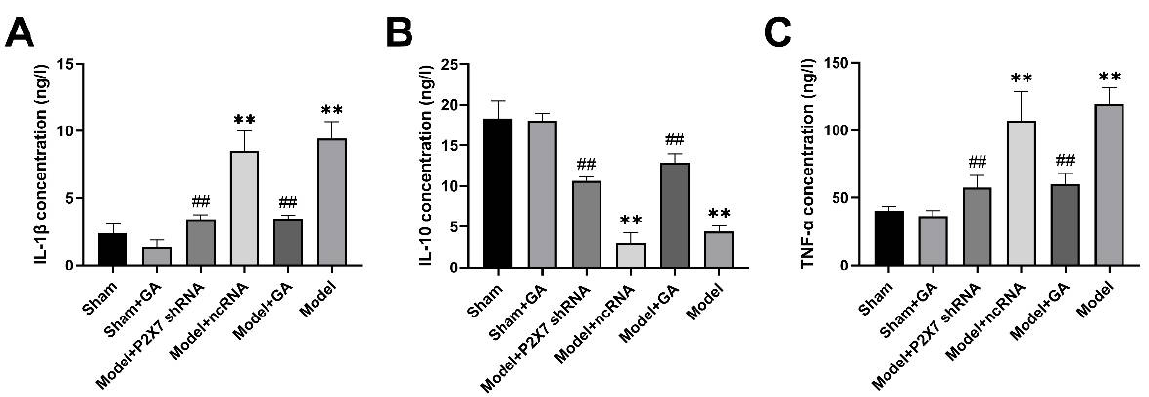
Figure 9. The effects of GA on the concentration of interleukin 1 β (IL-1 β ) ( A ) (F(5,30) = 85.322, p < 0.001); interleukin 10 (IL-10) ( B ) (F(5,30) = 172.816, p < 0.001); and tumor necrosis factor α (TNF- α ) ( C ) (F(5,30) = 56.655, p < 0.001) in the serum of rats in each group were assessed using ELISA. Values are means ± SEM. N = 6 per group. ** p < 0.01 vs. sham group; ## p < 0.01 vs. model group.